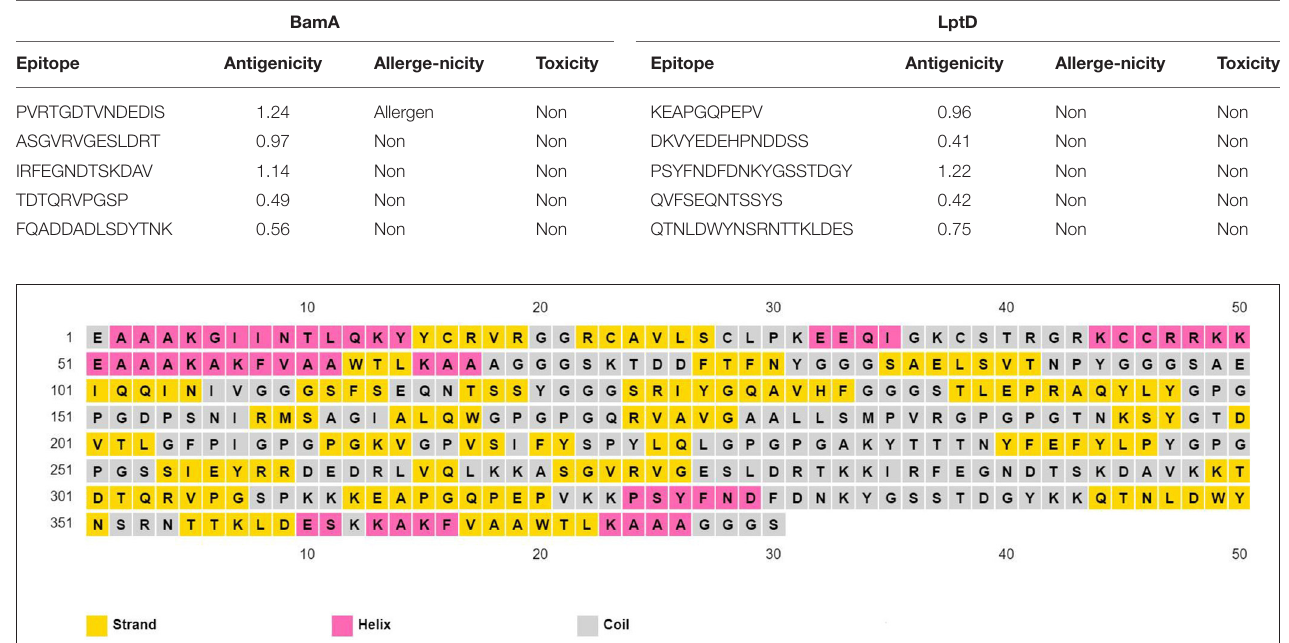
This construct was assessed to be non-allergen with an antigenicity score of 1.07 (estimated by VaxiJen v2.0) and 0.959 (estimated by ANTIGENpro).